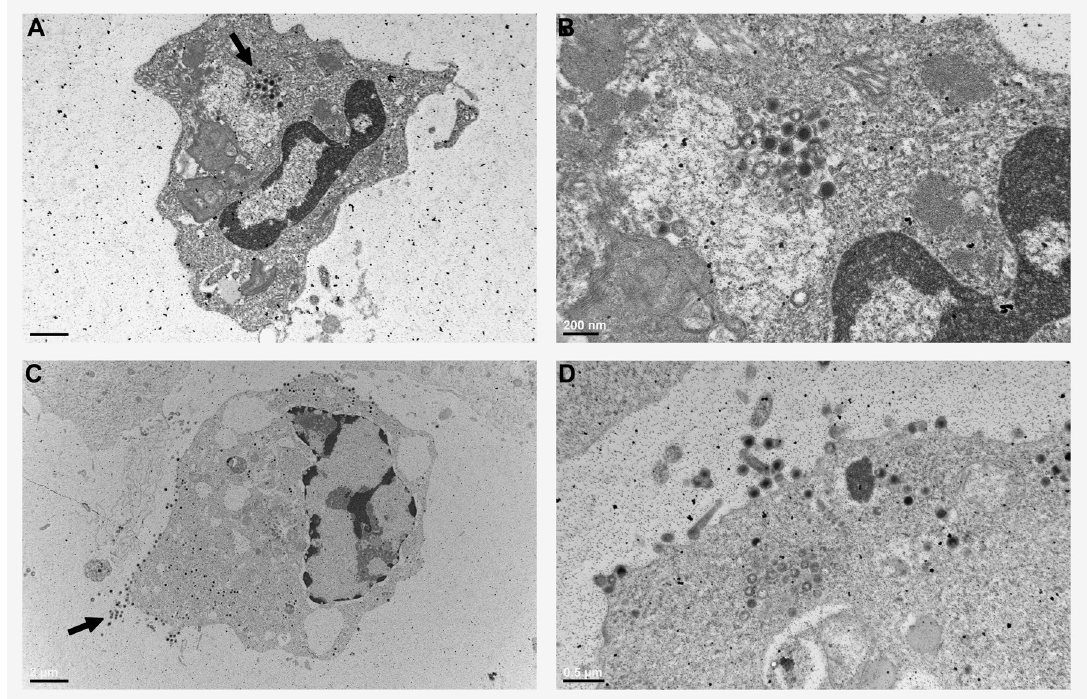
Figure 1. Electron micrographs of peritoneal macrophages from FV3-infected Xenopus laevis adults. Peritoneal leukocytes were collected from frogs 2 days subsequent to infection with 5 × 10 6 PFU of FV3, processed and visualized under a Hitachi 7650 TEM. ( A ) Mononucleated macrophage-like cells with an intracellular pool of FV3 virions (arrow, scale bar: 2 μ m). ( B ) A magnified image of the intracellular macrophage pool of FV3 virions (scale bar: 200 nm). ( C ) A macrophage-like cell shedding viral particles (arrow, scale bar: 2 μm). ( D ) A magnified image of a virus- shedding macrophage (scale bar: 0.5